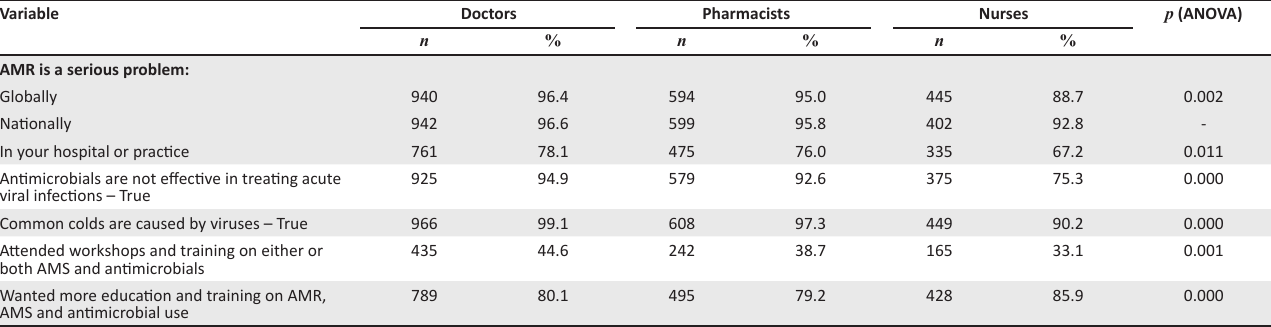
TABLE 1: Healthcare professionals’ responses on awareness, knowledge and education on antimicrobials, antimicrobial resistance and antimicrobial stewardship. Variable